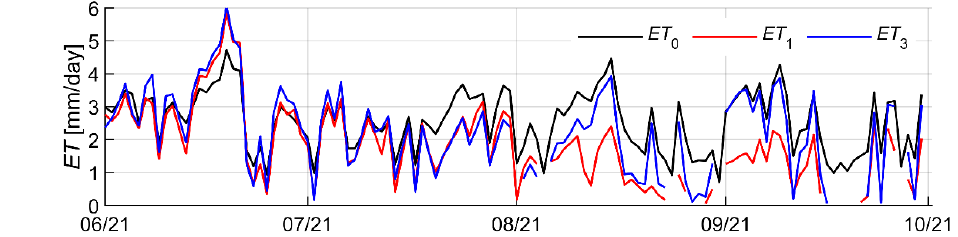
Figure 7. Evapotranspiration of test samples compared with reference